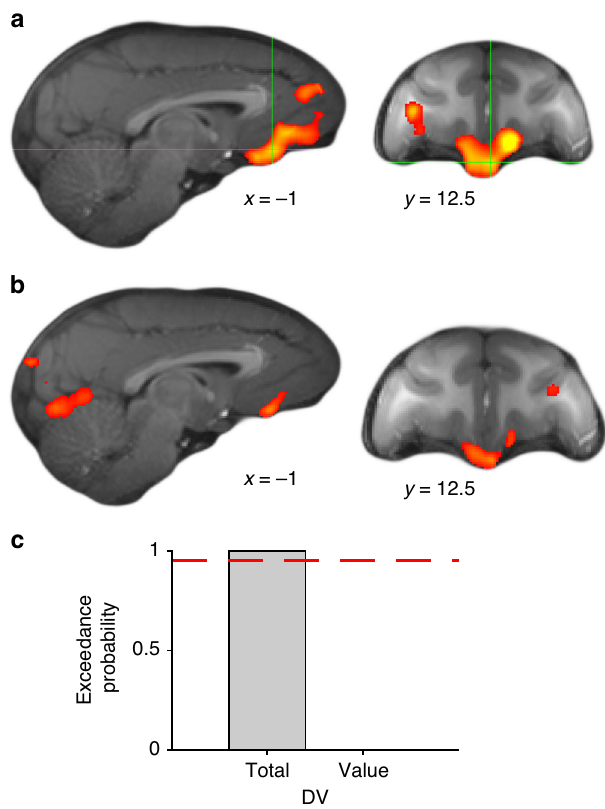
Fig. 9 Decomposition of vmPFC and DRN activity in value and choice. a Effects of DV total in vmPFC/mOFC. b DV value , the part of DV total re fl ecting the value difference between chosen and unchosen options, correlated with a similar vmPFC area, but signal sizes were weaker. c Bayesian model comparison suggests vmPFC activity is better described by DV total than by DV value . ROIs were determined using a leave-one-out procedure. The dashed red line indicates an exceedance probability of 0.95 ( n = 25 sessions; all MRI results cluster-corrected at Z > 2.6, p = 0.05). Source data are provided as Source Data fi le.